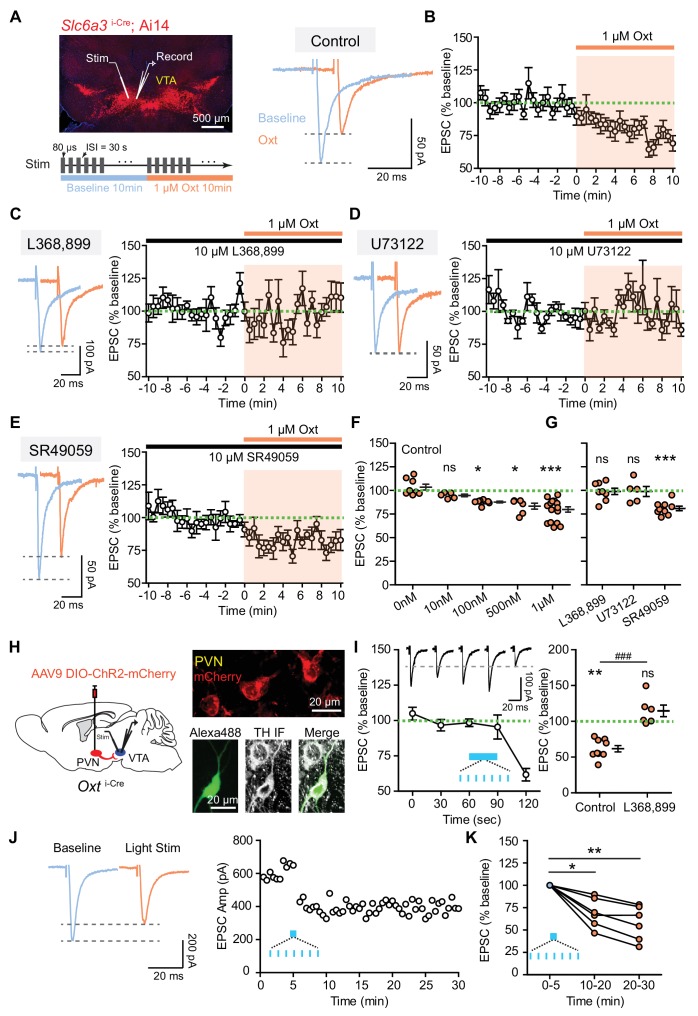
Oxytocin inhibits excitatory synaptic transmission in VTA DA neurons via the OxtR.(A) Left, top: an image of a horizontal brain section from a Slc6a3i-Cre; A14 mouse. A stimulation electrode (Stim) was placed ~100 μm away from the recording electrode (Record). Left, bottom: experimental protocol schematic. Right: example traces of evoked EPSCs from one VTA DA neuron during baseline and following 1 μM oxytocin application. Blue, baseline; orange, following oxytocin application. (B) The amplitude of evoked EPSC decreased during the application of 1 μM oxytocin. n = 15 neurons from 10 mice. Green dashed line, baseline EPSC amplitude average; shaded region, time of oxytocin application. (C) OxtR antagonist L368,899 blocked oxytocin-induced EPSC amplitude attenuation. Left: example traces from one neuron before and during oxytocin application. Right: summary data for n = 8 neurons from six mice. (D) Same as (B), but with a phospholipase C blocker U73122. n = 5 neurons from four mice. (E) Same as (B), but with a vasopressin receptor (V1aR) antagonist SR49059. n = 9 neurons from six mice. (F) Summary data for EPSC amplitude changes induced by oxytocin at different concentrations (0 nM, 10 nM, 100 nM, 500 nM, and 1 μM). For each concentration respectively, n = 8 neurons from five mice, 5 neurons from two mice, 8 neurons from four mice, 6 neurons from five mice, and 15 neurons from 10 mice. *p<0.05, ***p<0.001, Kruskal-Wallis test with Dunn’s Multiple Comparison post hoc test. (G) Summary data for oxytocin-induced EPSC amplitude changes in the presence of OxtR antagonist (L368,899), PLC blocker (U73122), and V1aR antagonist (SR49059). Wilcoxon signed rank test vs. baseline, ***p<0.001. (H) Left: Schematic of viral transduction strategy using AAV9-DIO-ChR2-mCherry to express ChR2 in PVN oxytocinergic neurons. Right, top: ChR2-mCherry (red) expression in PVN. Right, bottom: One example neuron identified as dopaminergic during whole-cell recording with Alexa Fluor 488 dye included in the internal solution (green). Post hoc immunofluorescent labeling against tyrosine hydroxylase (TH, grayscale) confirms its identity. (I) Left: Optical activation of oxytocin fibers in the VTA decreased evoked EPSC amplitude in DA neurons. Patterned light stimulation period is marked in blue. n = 9 neurons from six mice. Inset shows evoked EPSC traces from one VTA DA neuron before and after light stimulation, temporally matched to average data. Black dashed line shows EPSC amplitude of the example neuron at t = 120 s, 30 s after the end of optogenetic stimulation train. Right: Summary data for light stimulation-induced EPSC amplitude changes with and without OxtR antagonist (L368,899). n = 6 neurons from four mice in the presence of OxtR antagonist. **p<0.01, Wilcoxon signed rank test vs. baseline. ###p<0.001, Mann-Whitney test. Error bars reflect SEM. (J) Left: example traces of evoked EPSCs from one VTA DA neuron during baseline (blue) and after 30 s long light stimulation of PVN oxytocin fibers. Right: EPSC amplitudes recorded from one neuron (same as Left) during baseline and after light stimulation. (K) Summary data for light stimulation-induced EPSC amplitude changes 10–20 min and 20–30 min after light stimulation. *p<0.05, **p<0.01, Kruskal-Wallis test with Dunn’s Multiple Comparison post hoc test, n = 6 neurons from four mice.10.7554/eLife.33892.006Figure 1—source data 1.Summary tables of evoked EPSC amplitudes from individual VTA DA neurons in response to oxytocin-signaling related pharmacological agents and optogenetic stimulation of oxytocin fibers.